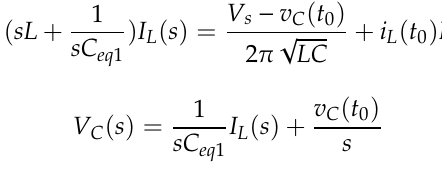
Figure 9. The proposed diagnostic system interface for the lithium battery module.